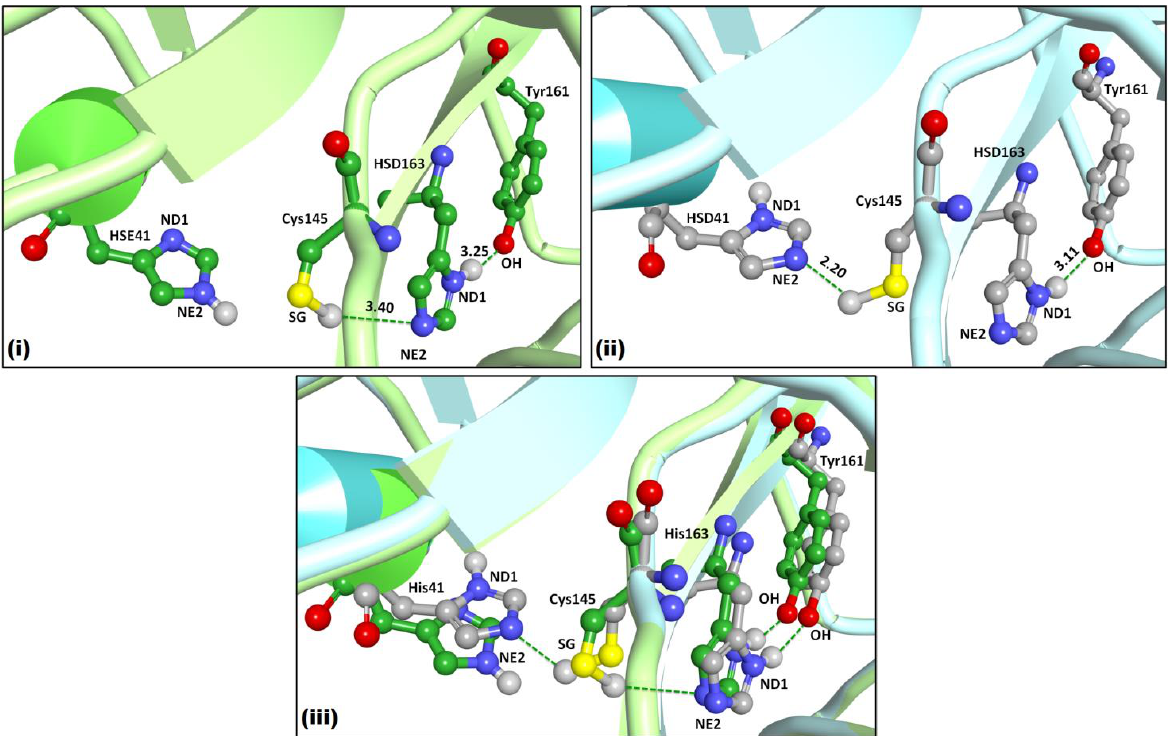
Figure 4. The His41 is protonated as HSE (at NE2) and HSD (ND1) form in 5RGL crystal structure and after its energy minimization, (i) H atom of thiol group at Cys145 moves towards NE2 of His163 to make H-bond when NE2 of His41 is protonated as HSE. (ii) Corresponding H atom changes its conformation toward NE2 of His41 when ND1 of His41 is protonated as HSD. (iii) The superimposed energy minimized structures between HSD41 and HSE41 have clearly explored the change of orientation of H atom from His163 towards